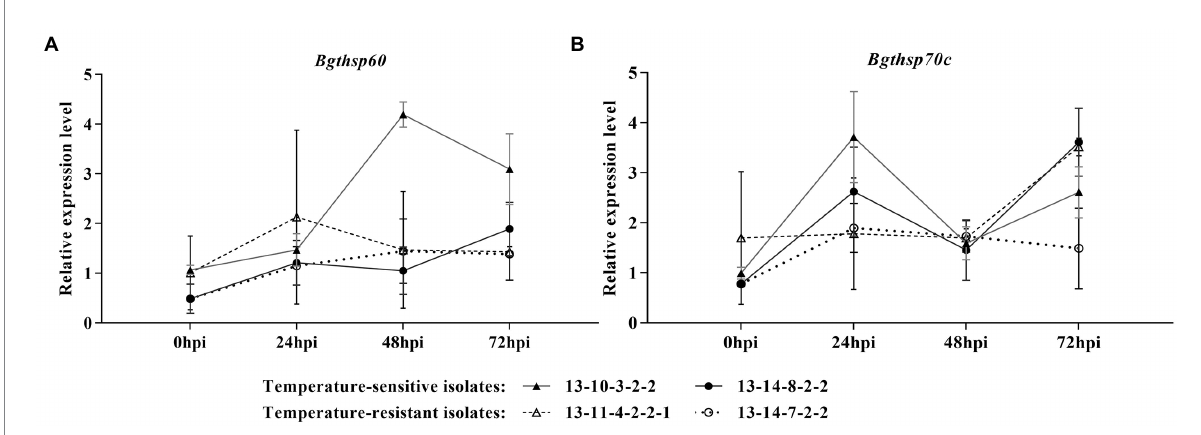
FIGURE 5 Time course of gene expression level of Bgthsp60 (A) and Bgthsp70c (B) in high-temperature-sensitive and resistant isolates at 25 ° C. Infected leaf segments by B. graminis f. sp. tritici isolates were collected at 0, 24, 48, and 72 h post-inoculation (hpi). β -tubulin was used as reference gene and 0 hpi of the one independent repeat of 13–10–3-2-2 as reference sample. The error bar showed standard error of three independent